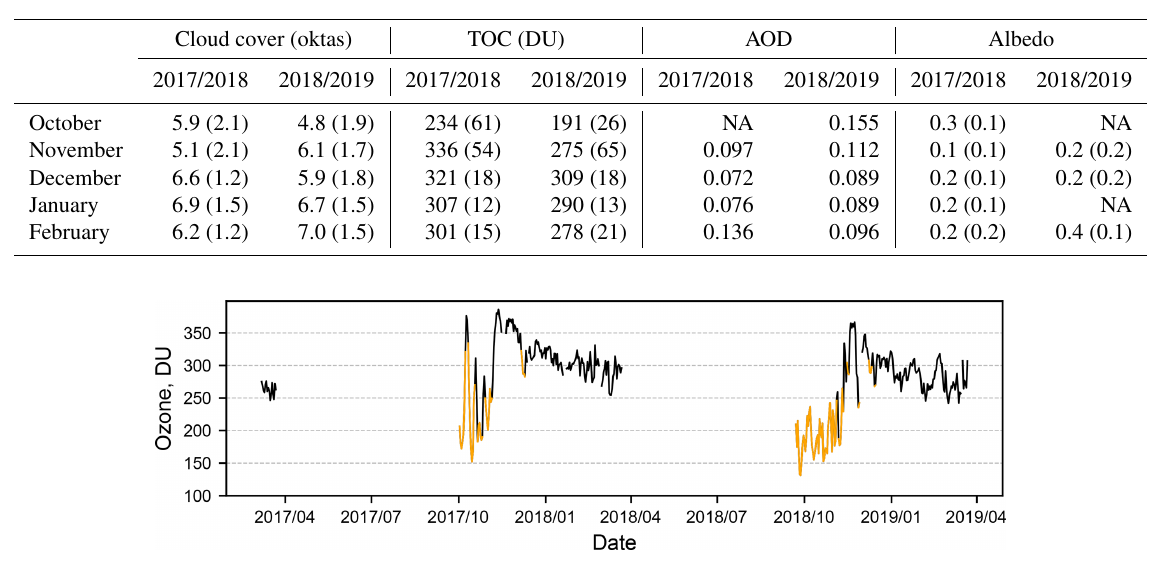
Figure 5. Daily average TOC at Marambio calculated from GUV measurements with SZA < 65 ◦ (2017–2019). Days during which the station was inside the polar vortex (vorticity < − 36) are in orange.